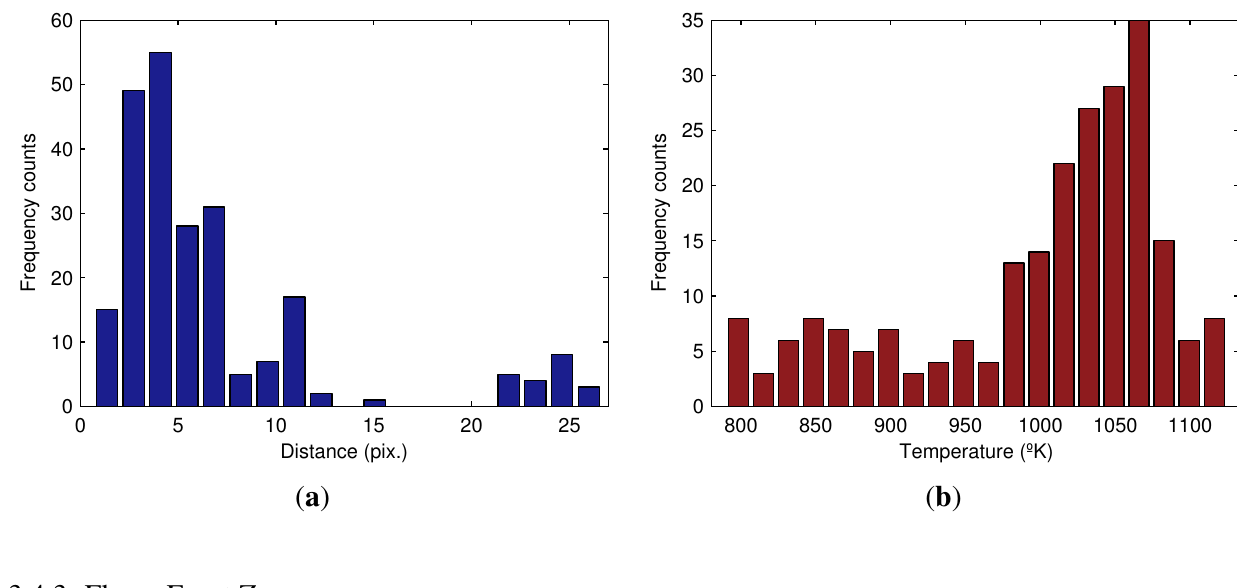
Figure 11. Histograms for the hot zone. ( a ) Histogram of the distance from the maximum temperature values in the flame front to the bottom limit of the ROI; ( b ) histogram of the maximum temperature values in the flame front.